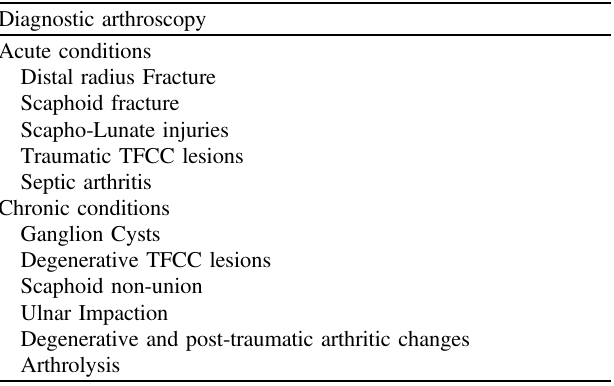
Table 1. Wrist arthroscopy main indications summary. Diagnostic